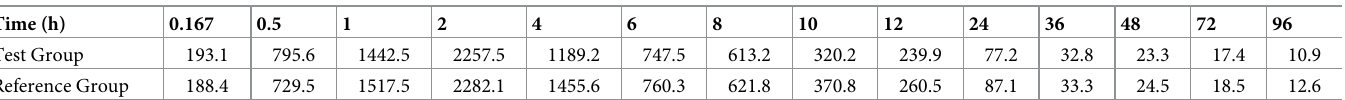
Table 2. Average concentration of IMD in cattle plasma at different sampling time points in a test group and a reference group (ng/mL)n = 24. Time (h) 0.167 0.5 96 Test Group 193.1 795.6 Reference Group 188.4